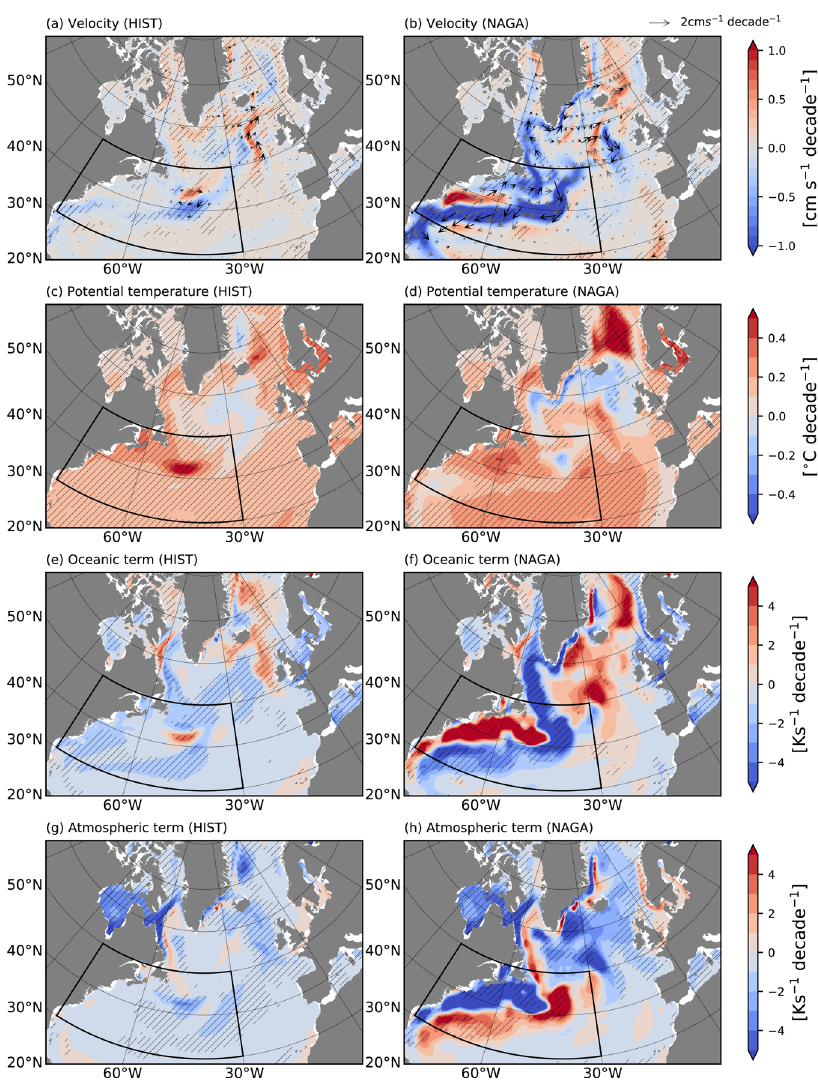
Fig. 4 Linear trends of the potential temperature and horizontal velocity vertically-averaged within the surface mixed layer in the North Atlantic for NAGA and HIST. Linear trends in the DJF mean horizontal current (vector) and velocity (colors) [cm s − 1 decade − 1 ] for a HIST and b NAGA. The horizontal velocity is vertically averaged within the surface mixed layer. The hatching and black vectors indicate statistically signi fi cant linear trend. The black solid box shows the area in which SST anomalies are restored to the observations in NAGA. c – h As in a and b , but for c and d for potential temperature [°C decade − 1 ], e and f oceanic contribution to the mixed layer temperature tendency [Ks − 1 decade − 1 ] (Eq. 3), and g and h atmospheric contribution to the mixed layer temperature tendency [Ks − 1 decade − 1 ] (Eq.